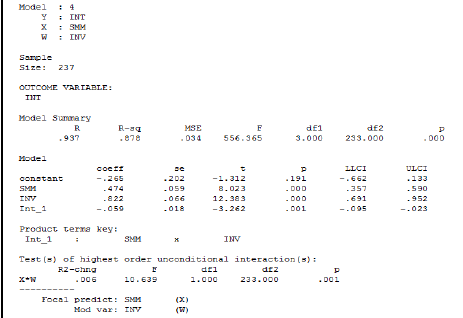
Fig. 7. Interaction Plot - Moderation Effect of Customer